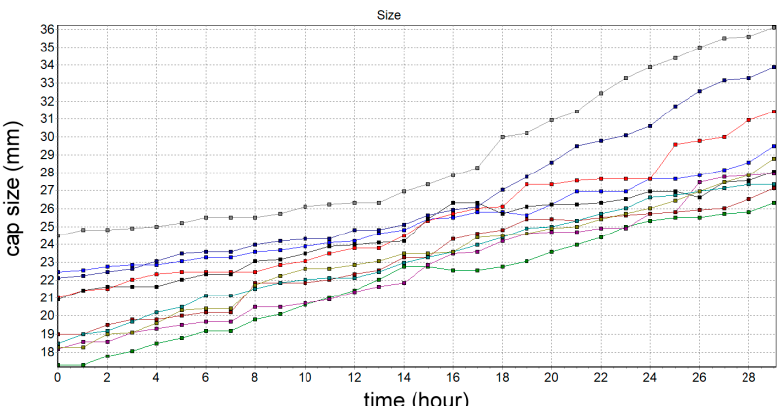
Figure 13. The number of detected mushrooms in 29 h.